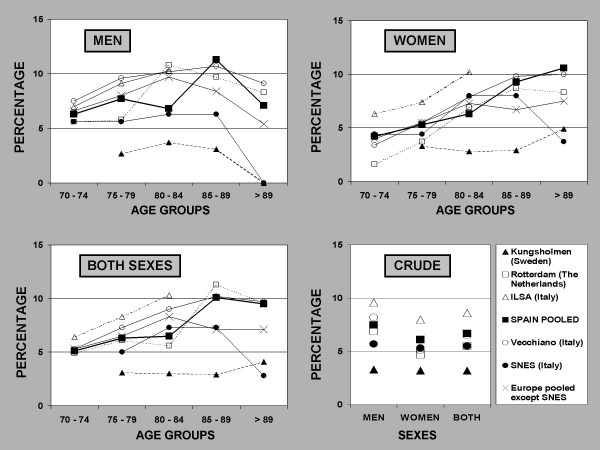
Crude and age-specific prevalence of stroke in pooled Spanish and in European populations.